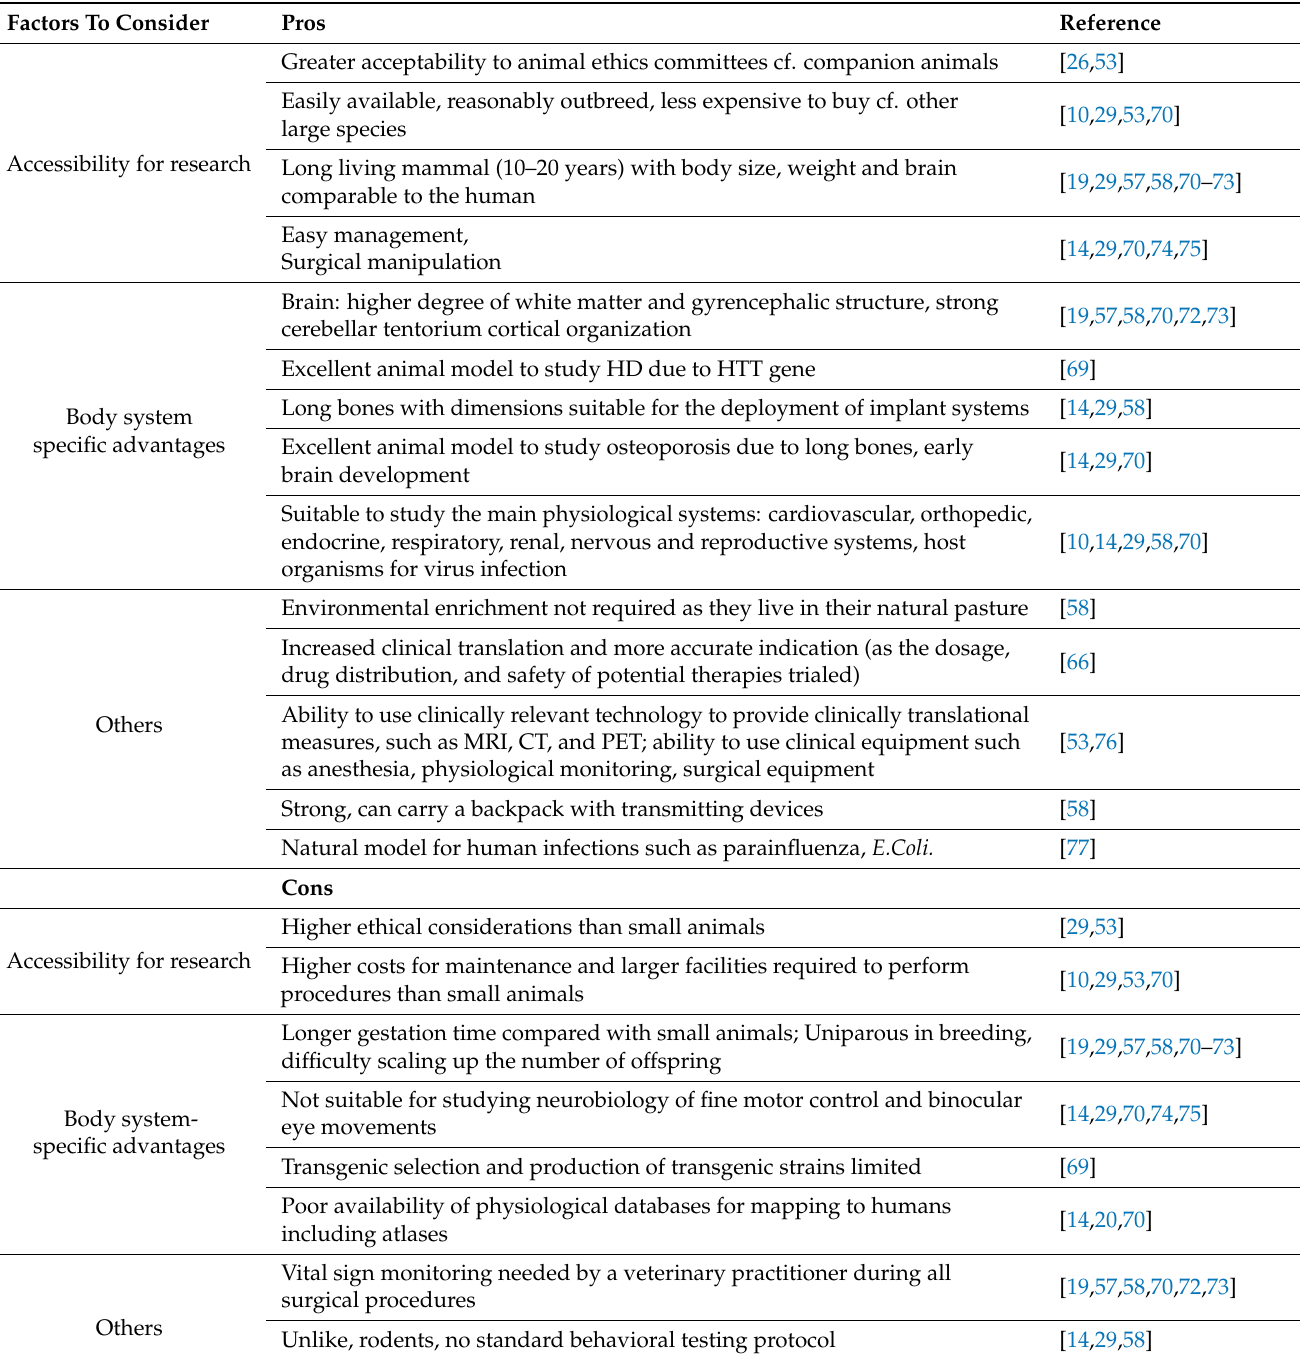
Table 3. The pros and cons of using sheep as an experimental animal model for translational research compared to other animal